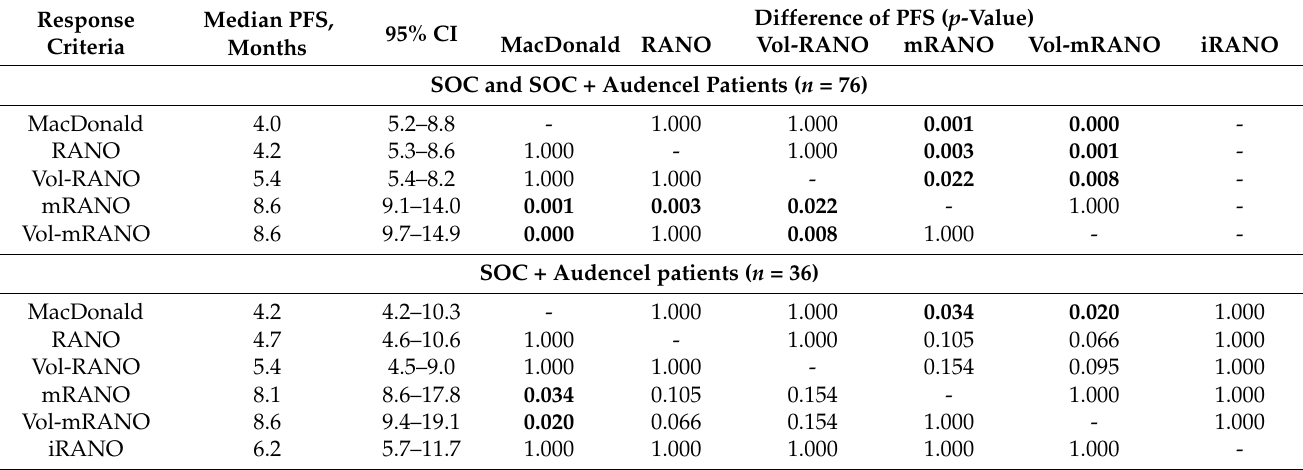
Table 3. Median progression-free survival with the corresponding confidence interval for the different assessment criteria. Calculated p -values (Kruskal–Wallis test) and corrected for multiple testing (Bonferroni’s adjustment) for difference in PFS between assessment criteria.